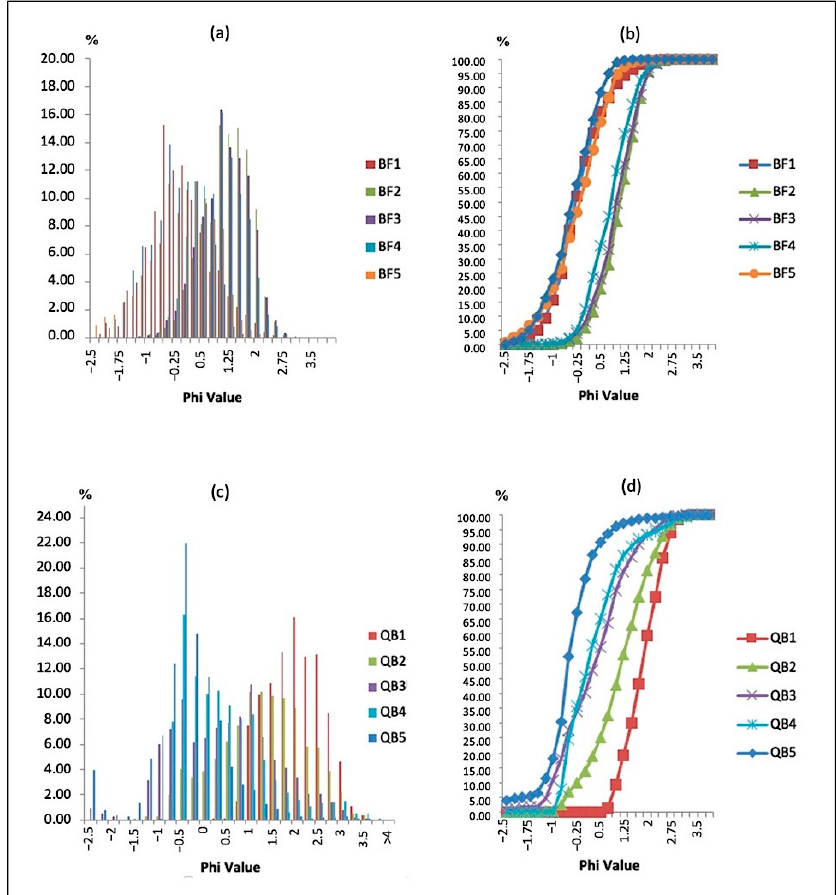
Figure 10. Comparing grain size and cumulative frequency of samples at Batu Ferringhi ( a , b ) and Persiaran Bayan Lepas ( c , d ).